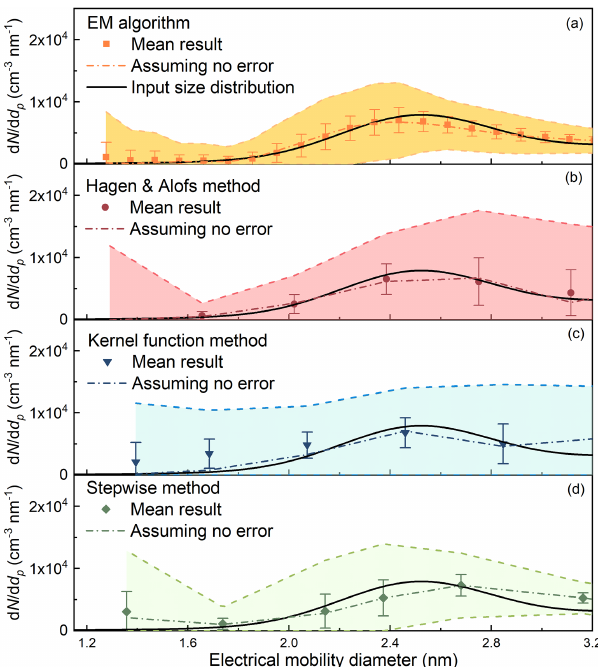
Figure 11. The recovered particle size distributions simulated using the Monte Carlo method when assuming the relative standard devi- ation of the recorded particle number concentration are 10%. The reported size bins smaller than 1.3nm recovered using the kernel function method and the stepwise method are not shown because of the large uncertainties.